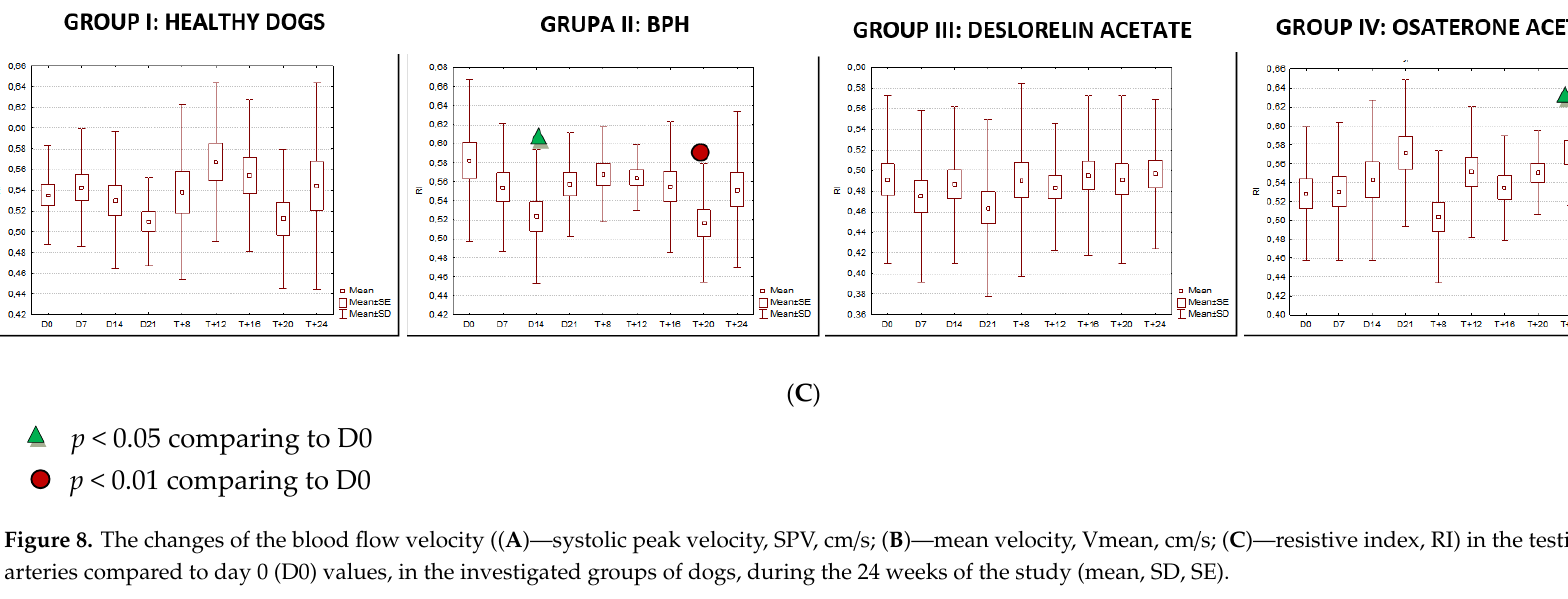
Figure 8. The changes of the blood flow velocity (( A )—systolic peak velocity, SPV, cm / s; ( B )—mean velocity, Vmean, cm / s; ( C )—resistive index, RI) in the testicular arteries compared to day 0 (D0) values, in the investigated groups of dogs, during the 24 weeks of the study (mean, SD, SE).